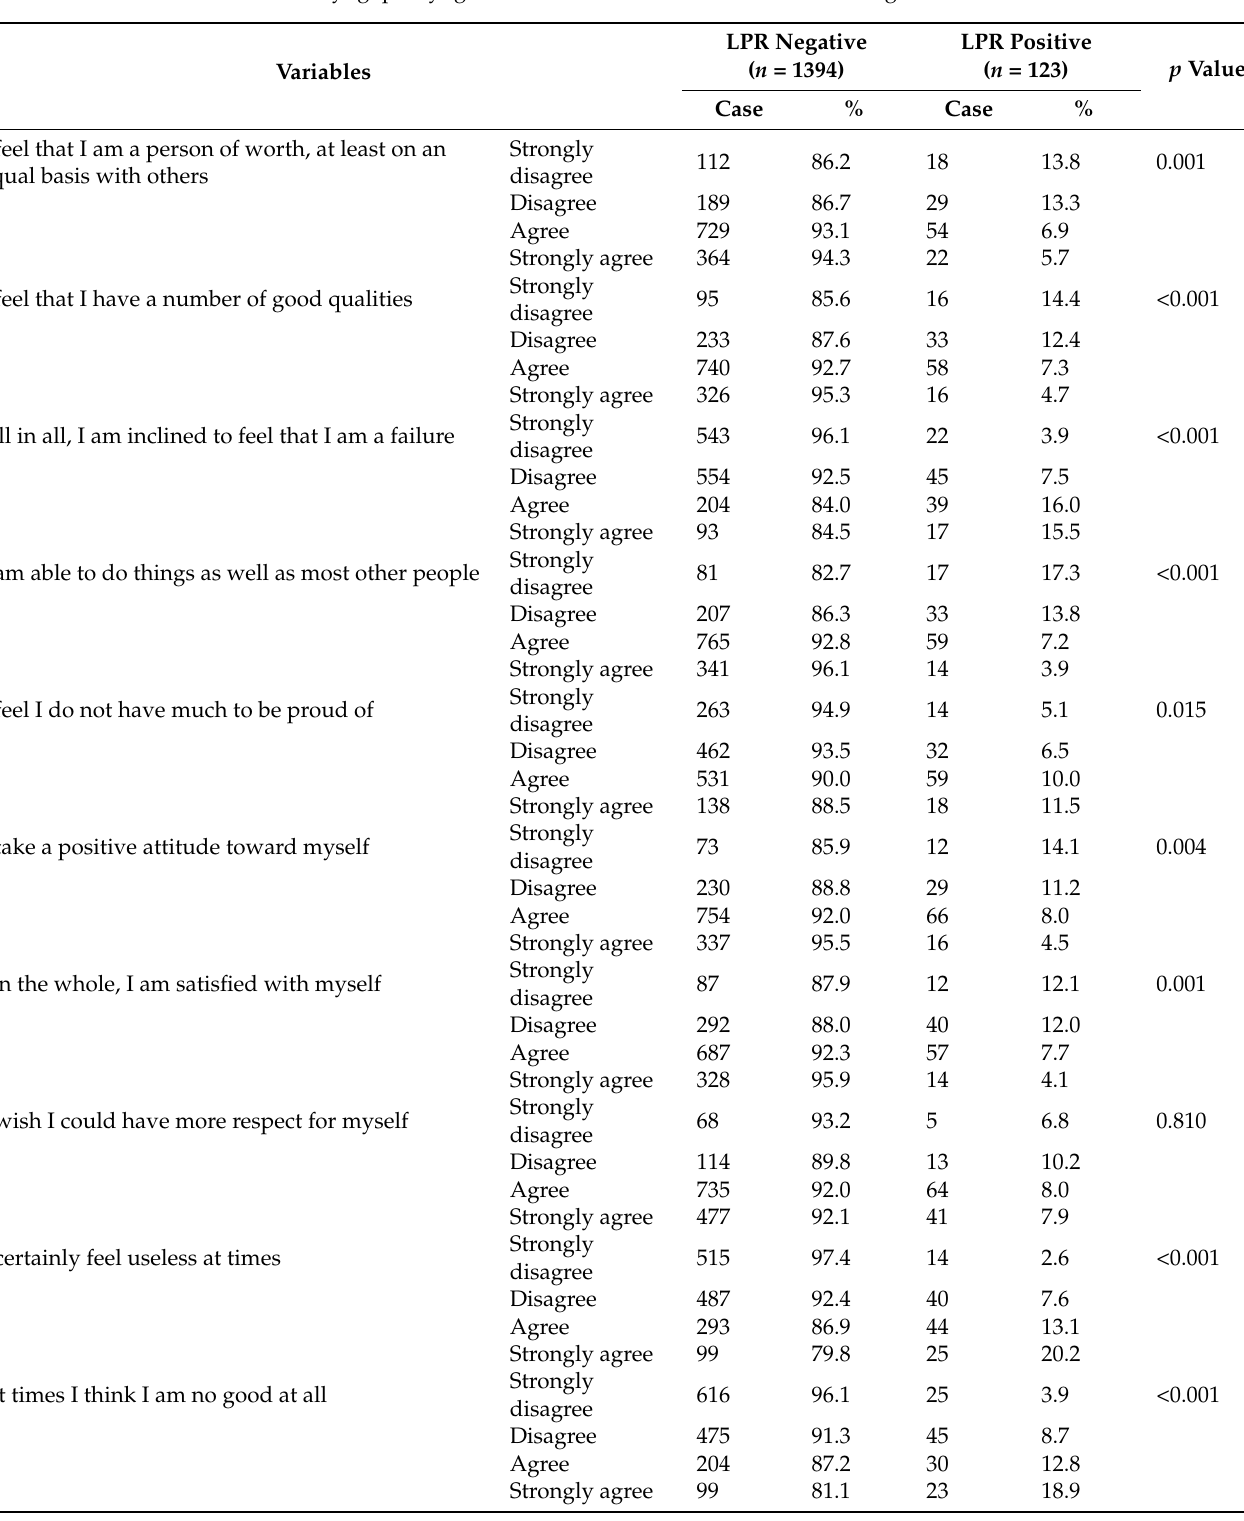
Table A6. The laryngopharyngeal reflux condition and items of Rosenberg Self-Esteem Scale. Variables